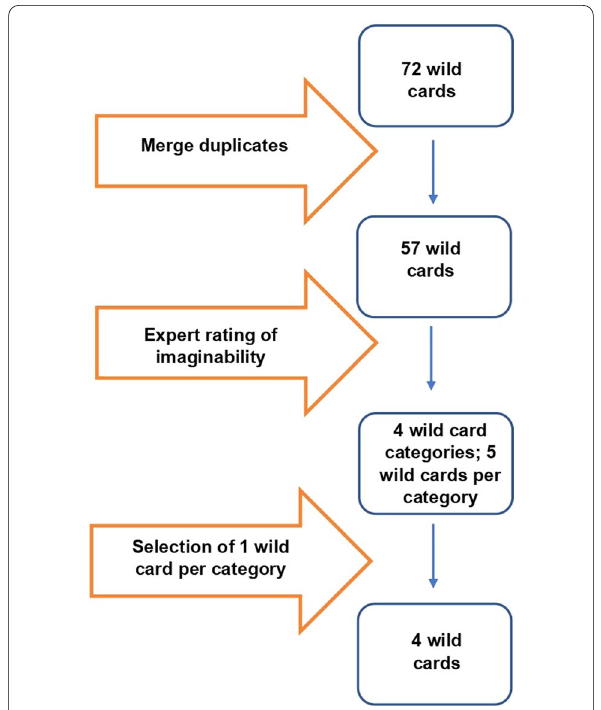
Fig. 4 Wild card selection